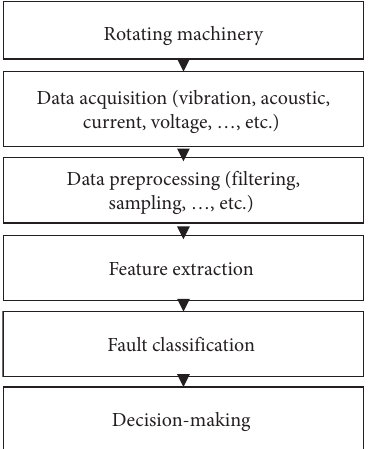
Figure 5: General block diagram of FDD using machine